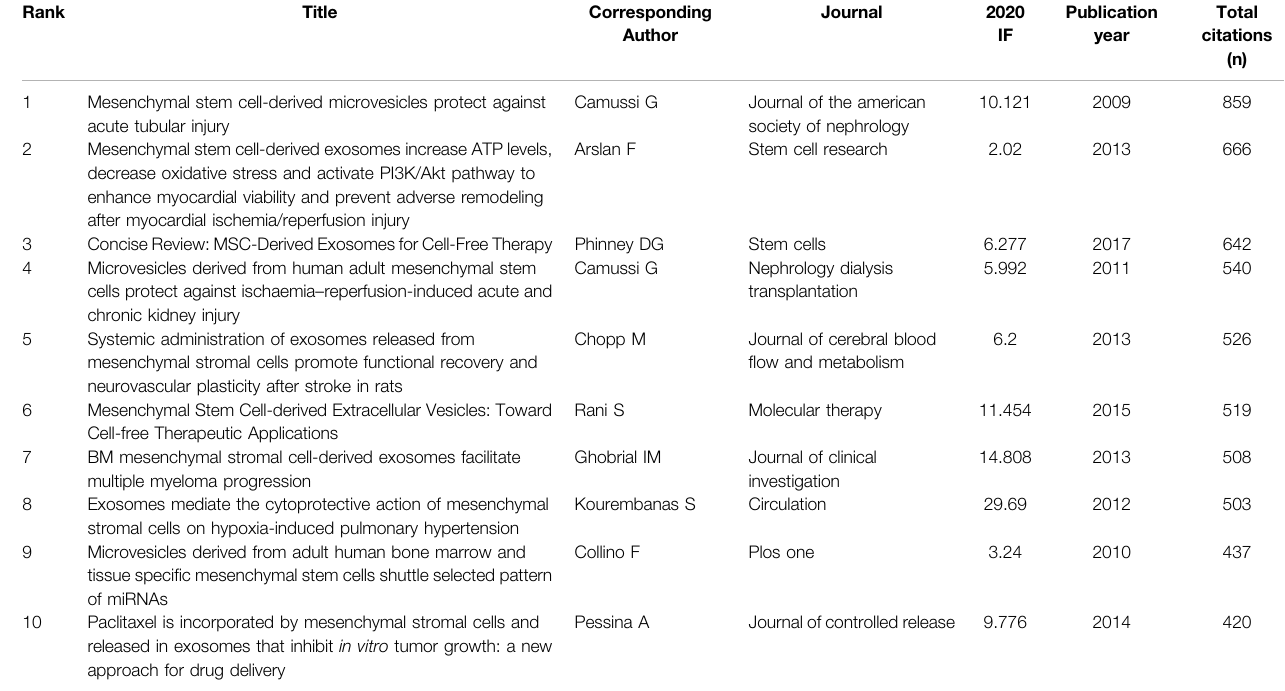
TABLE 5 | The top 10 documents with the most citations in the fi eld of MSC-EVs.